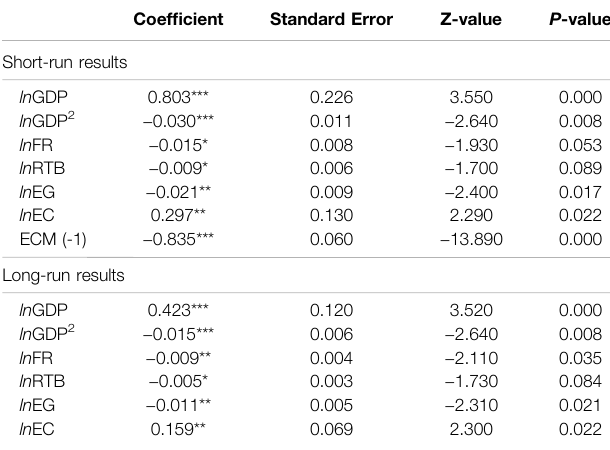
TABLE 7 | Short-run and long-run test results.